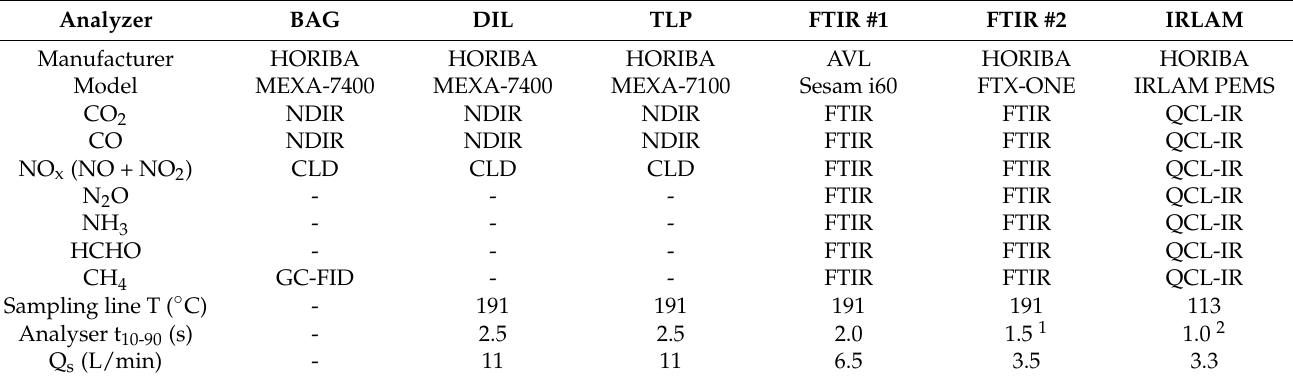
Table 1. Characteristics of instruments and principles of